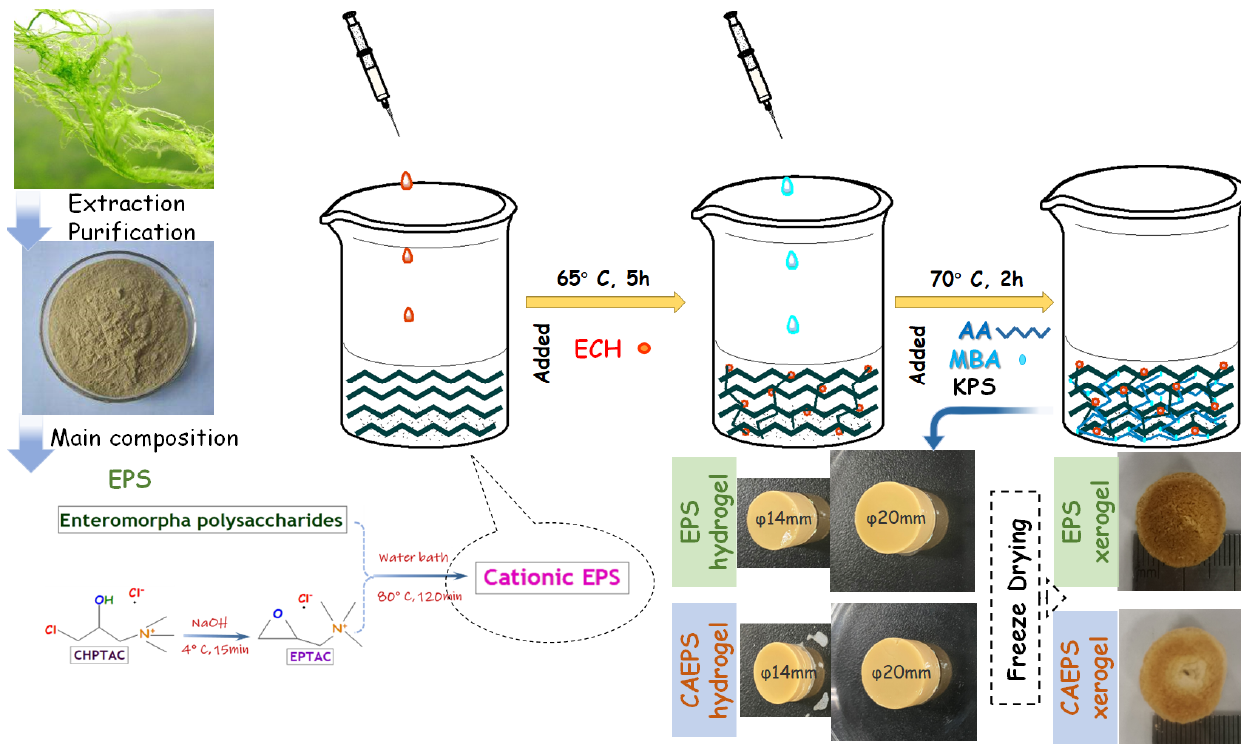
Figure 11. The fabrication process of the EPS and CAEPS-based double network